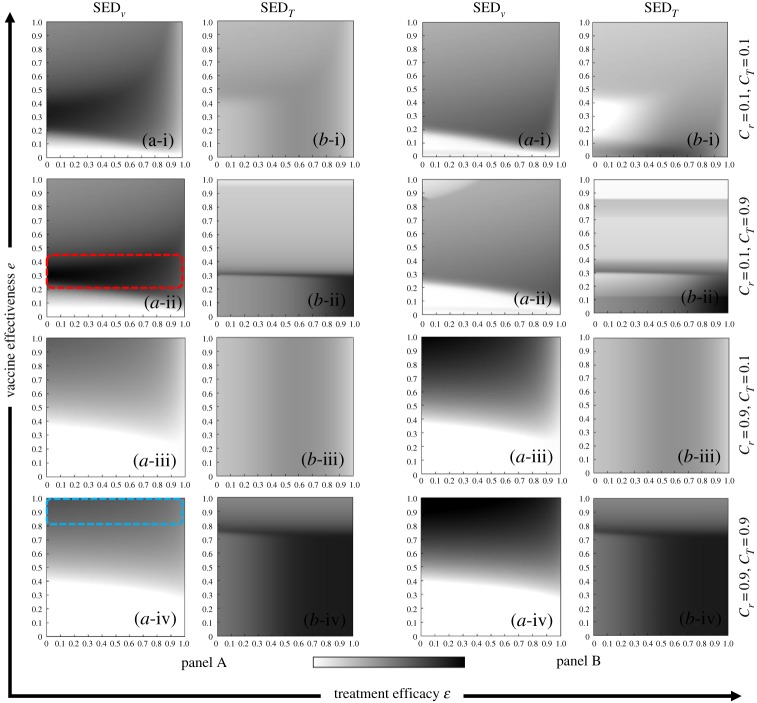
Phase diagram of SED, panels A and B present the results of IB-RA and SB-RA, respectively. In both panels, rows 1–4 display the vaccination and treatment costs (Cr, CT) as (*-i) (0.1, 0.1), (*-ii) (0.1, 0.9), (*-iii) (0.9, 0.1) and (*-iv) (0.9, 0.9). Meanwhile, the first and second columns of both panels show (a-*) SEDv and (b-*) SEDT.